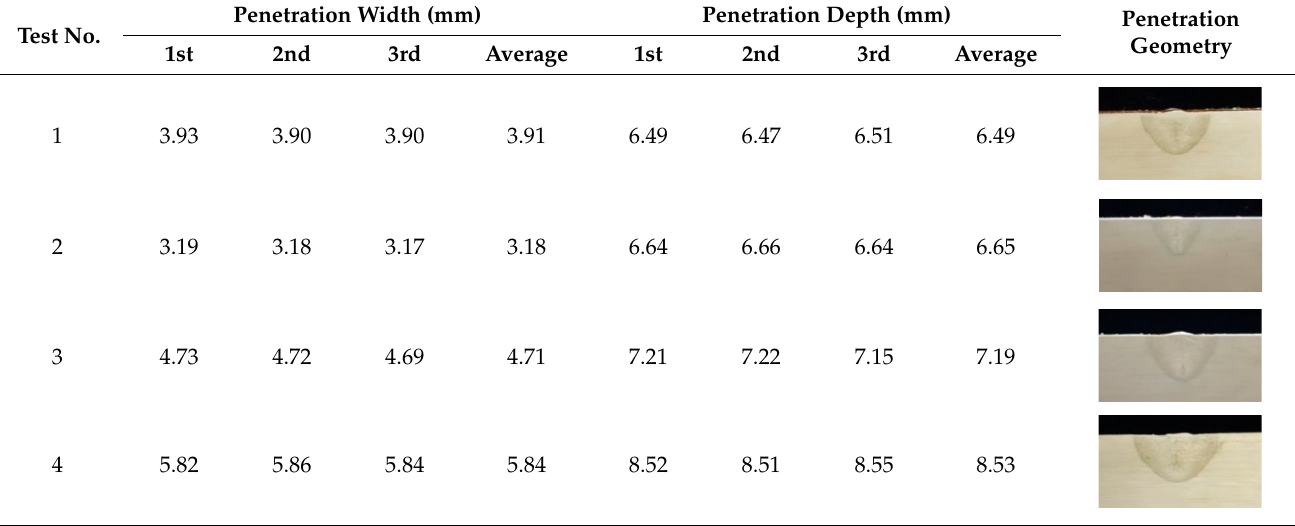
Table 5. Results and Penetration Data.